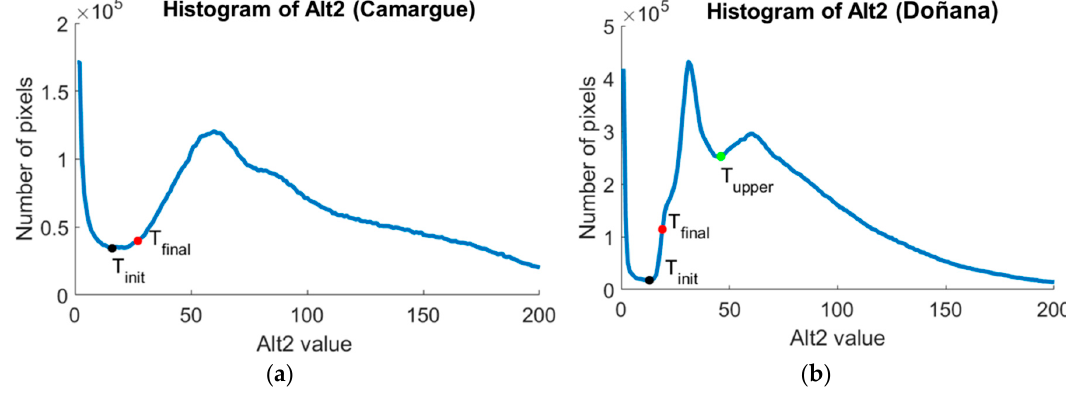
Figure 4. Histogram of the Alt2 map for ( a ) Camargue on 18 August 2017, and ( b ) Doñana on 20 August 2017. T init is the value for which the first deep valley in the Alt2 histogram is detected (black point). The red point on the Alt2 histogram corresponds to the final Alt2 threshold T final estimated by relying on MCET. The deep valley right after the first valley in the Alt2 histogram, detected only on the right histogram, corresponds to threshold T upper (green point). Histogram values reach up to 255 normalized intensity value. However, since there are a few pixels with an Alt2 value over 200 and they do not cause fluctuations of the Alt2 histogram curve, the upper limit of the x-axis is set to 200 for visualization reasons.